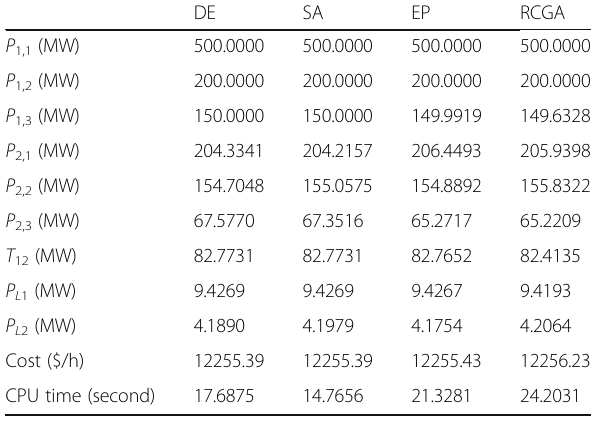
Table 1 Simulation results for test system 1